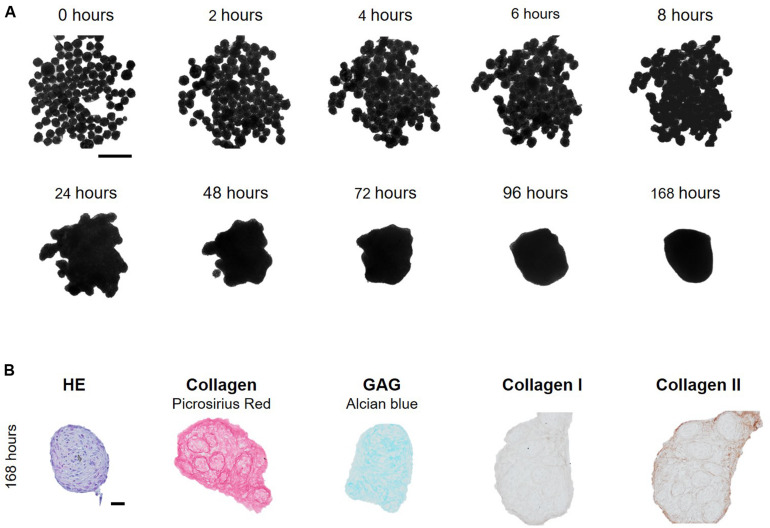
Formation of a macrotissue by fusion of multiple cartilage microtissues. (A) Cartilage microtissues at maturation stage of 7 days were harvested and ± 200 spheroids were seeded per agarose coated 96-well. Spheroid fusion was tracked for 168 h. Scale bar 500 μm. (B) Morphological and (immuno)histochemical evaluation of the fused microtissues after 168 h of culture. HE staining was performed to assess overall morphology, Alcian Blue staining showed the presence of glycosaminoglycans (GAG). Collagen was visualized by Picrosirius Red (PSR) staining and IHC stainings for collagen type I and type II were performed. Scale bar 20 μm.